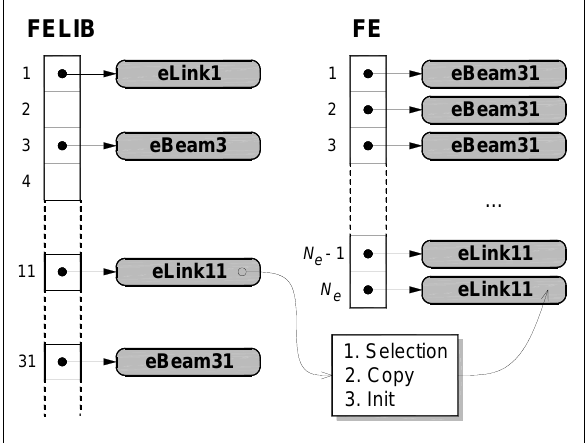
Fig. 18. Library-table of the objects of the finite elements FELIB and structural elements’ assemblage